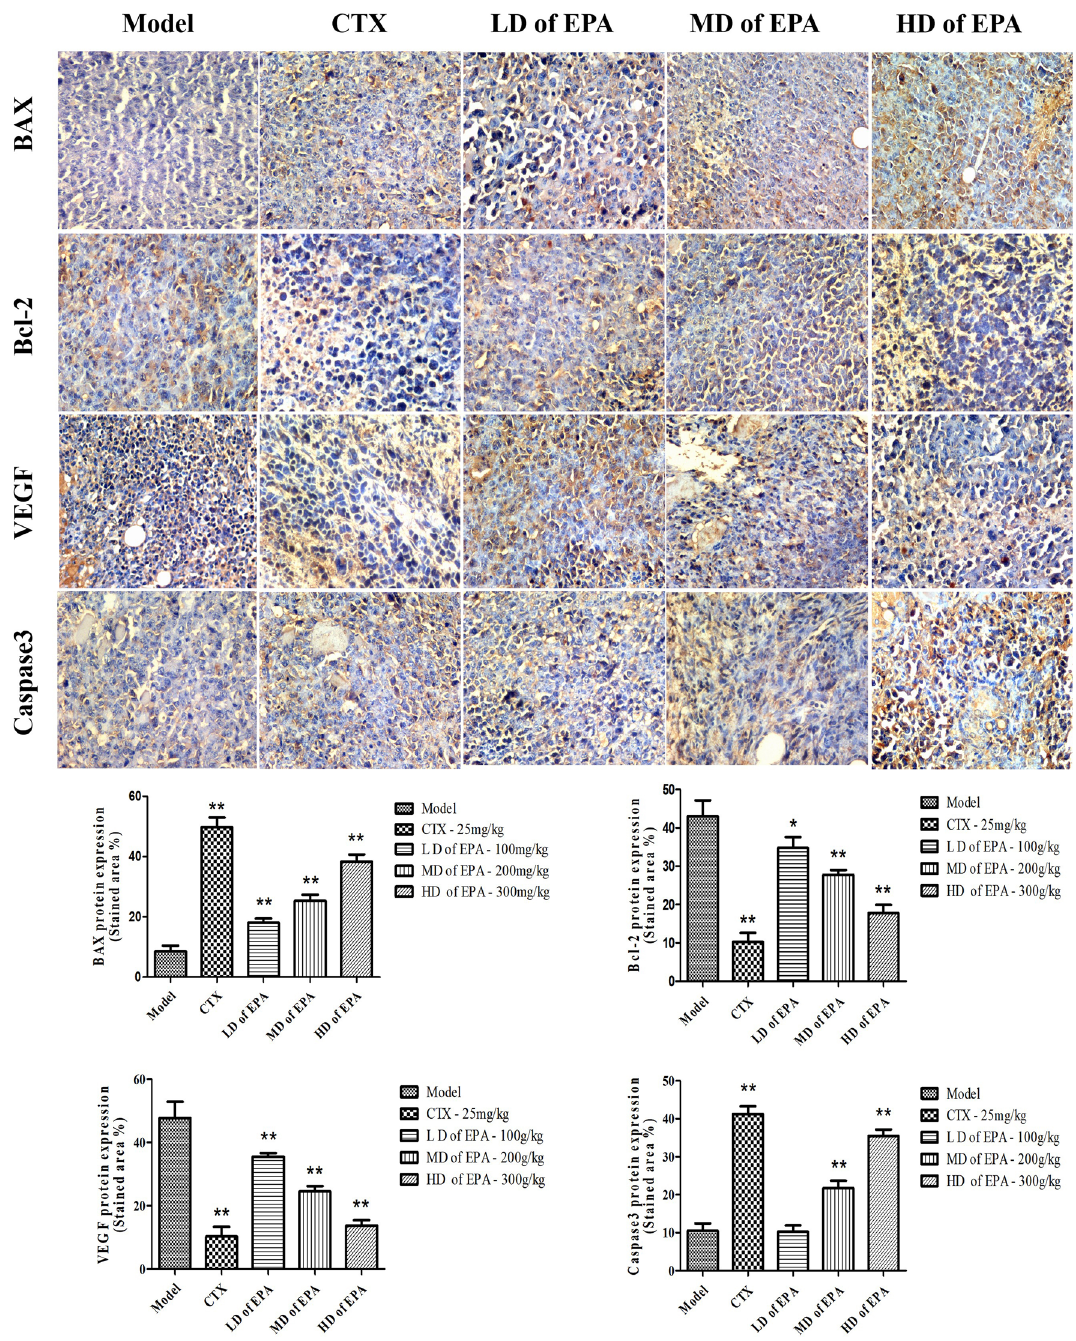
Figure 5. Immunohistochemical anylisis of tumor tissues and stained area of tumor